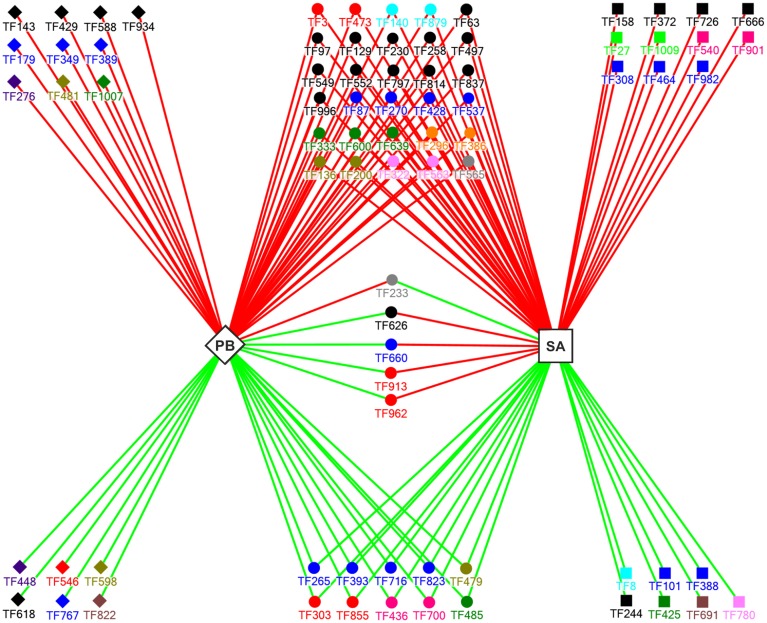
A model for the regulatory network that controls the expression of
E. Pisi-induced TF genes (p
= 0.05; −0.7 ≥ m ≥ 0.7) in Parabinga (PB; diamond) and SA1306 (SA; square)
M. truncatula
genotypes. Solid diamonds and solid squares indicate the TF genes regulated in Parabinga and SA1306, respectively. The TF genes that were regulated in both genotypes are indicated by solid spheres. Up- and down-regulation are indicated by red and green lines, respectively. The colors of the solid diamonds, solid squares, and solid spheres indicate TF families: Green (bHLH); black (HD family; HD-Like; MYB; MYB/HD-like); orange (ARF; GRAS); red (AP2/ERBP; WRKY); blue (Zn-fingers TF families; bZIP); olive green (FHA; NAC); violet (RR); pink (SBP; BTB/POZ); gray (HMG; HTH); brown (E2F; DDT); sky-blue (LIM; PHD); pea green (JUMONJI; ARID); dark pink (AUX/IAA; MADS). A detailed description of these genes is shown in Table S2.